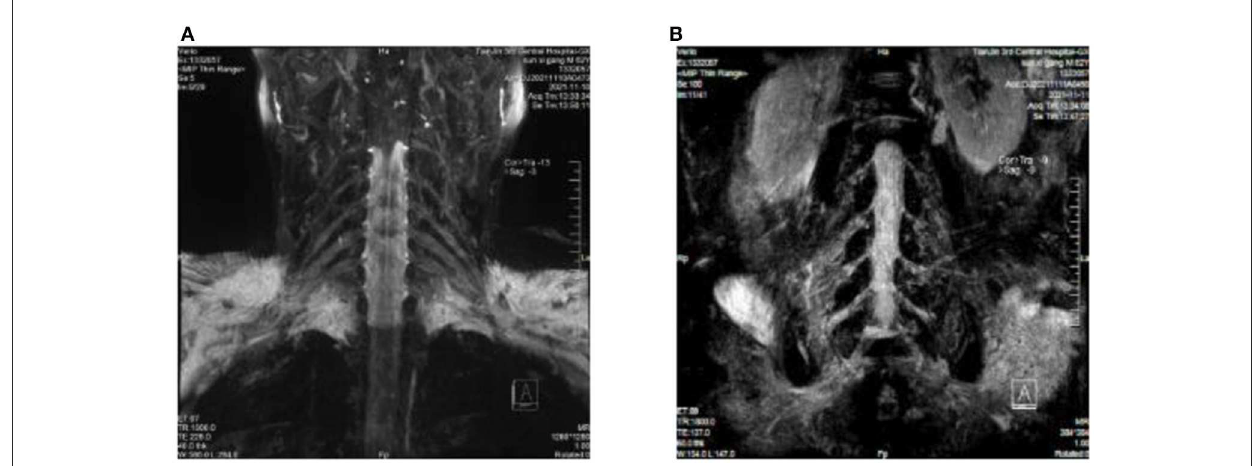
FIGURE1 (A) Cervical plexus MRI: fluid attenuation inversion recovery (FLAIR) shows slightly thickened bilateral nerve roots at C4/C5–C6/C7. (B) Lumbosacral plexus MRI: fluid attenuation inversion recovery (FLAIR) shows bilateral nerve root thickening at the L1/L2–L4/L5 intervertebral space, with slightly higher signal intensity, especially at L2/L3–L4/L5.